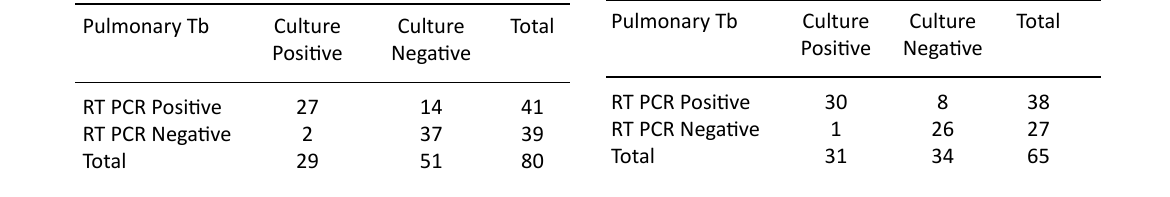
Table 4 . Comparison of Culture and RT PCR results